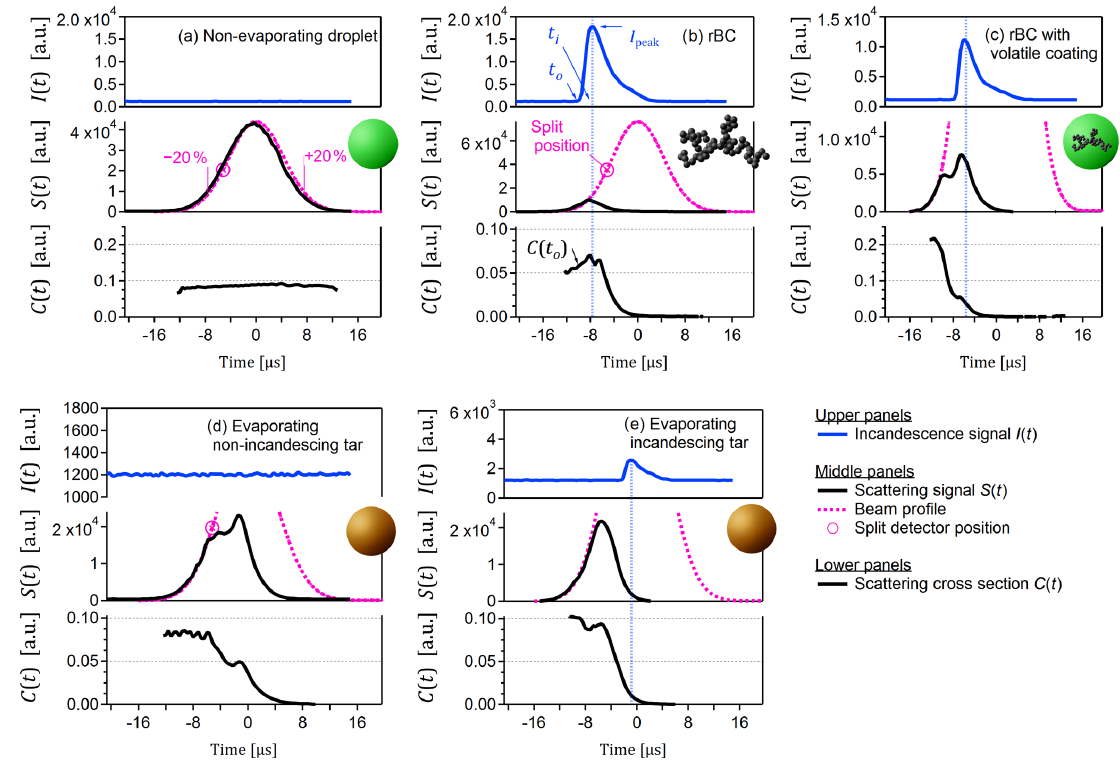
Figure 1. Particle types observed in this study. These examples were selected to be representative of the trends shown in subsequent figures. (a) Typical non-absorbing and therefore non-evaporating particle (likely lubrication oil/sulfate mixture). The labels − 20% and + 20% indicate fractions of maximum beam intensity. (b) Typical soot BC particle. (c) Atypical coated soot BC particle (rare in this data set, selected for illustration only). (d) Typical evaporating but non-incandescing tar particle. (e) Typical evaporating and incandescing tar particle. Note the difference between position of maximum incandescence (vertical blue lines) and position of stable C(t) in panels (c) and (e) , as highlighted by the vertical blue lines. Note also that the ordinate scales vary in order to highlight key